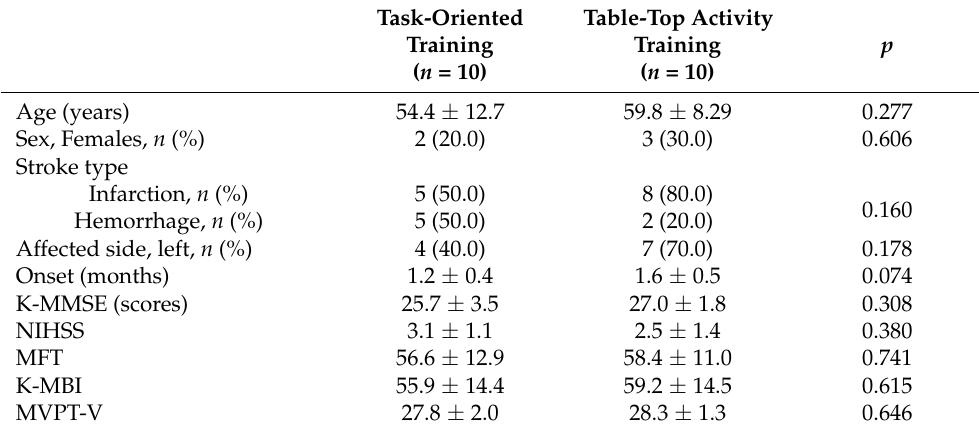
Table 3. General characteristics of the participants ( N =